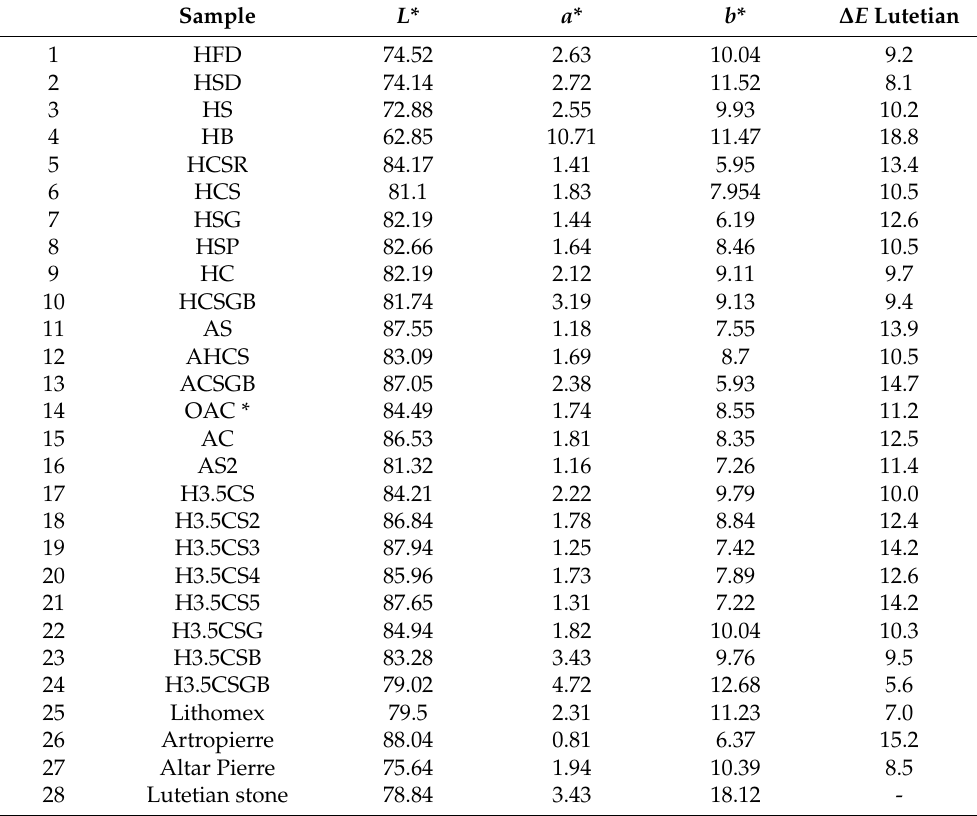
Table 5. Color of restoration mortars for Lutetian stone and selected commercial